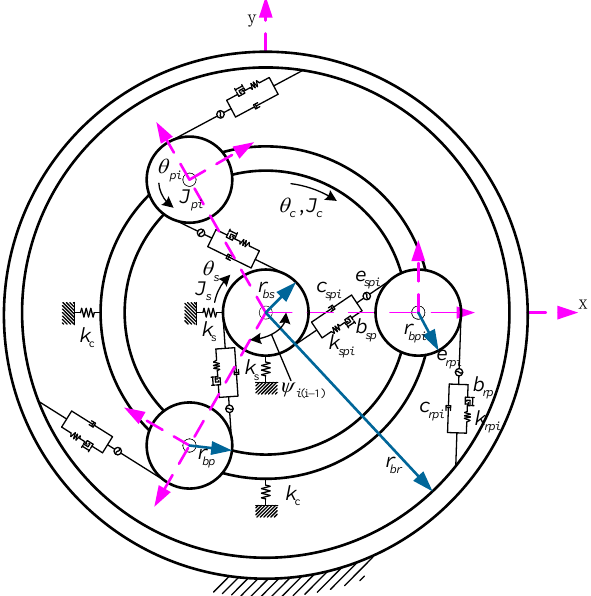
Figure 3. Schematic diagram of gear rotation error.